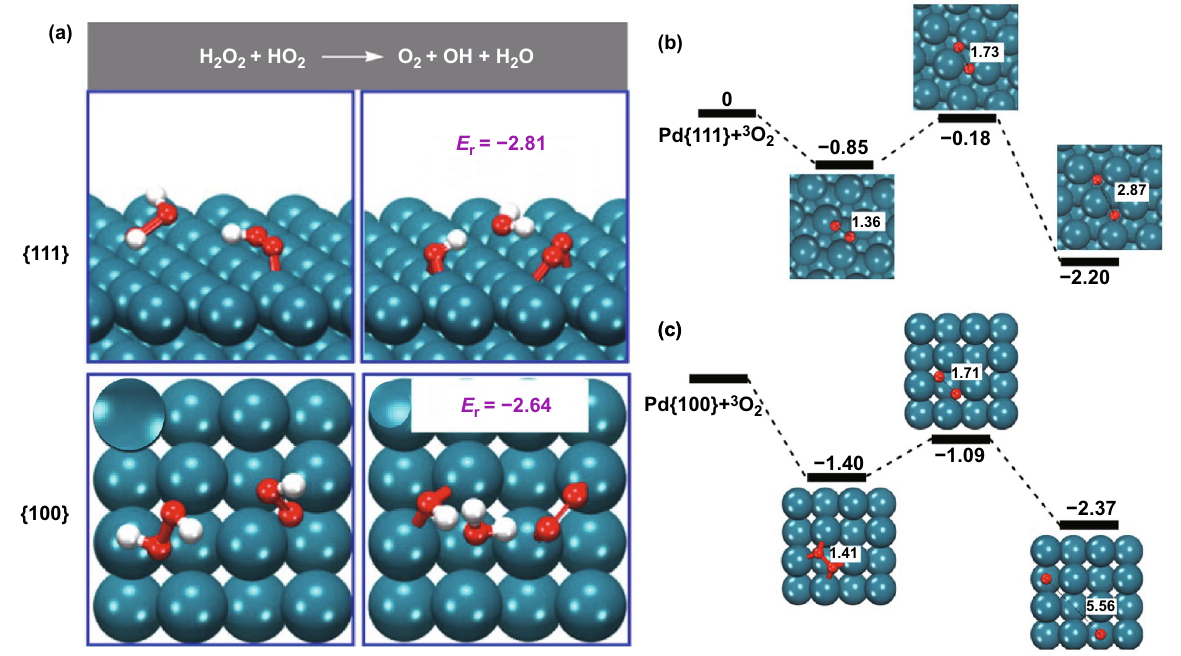
Fig. 6 a Lowest-energy adsorption structures and reaction energies (in eV) for the reactions on the Pd {111} and {100} facets. b , c Relative energies (eV) of O 2 dissociative adsorption and O–O atomic distances (Å) on the Pd {111} and {100} facets. Adapted from a Ref. [67], b , c Ref. [225] with